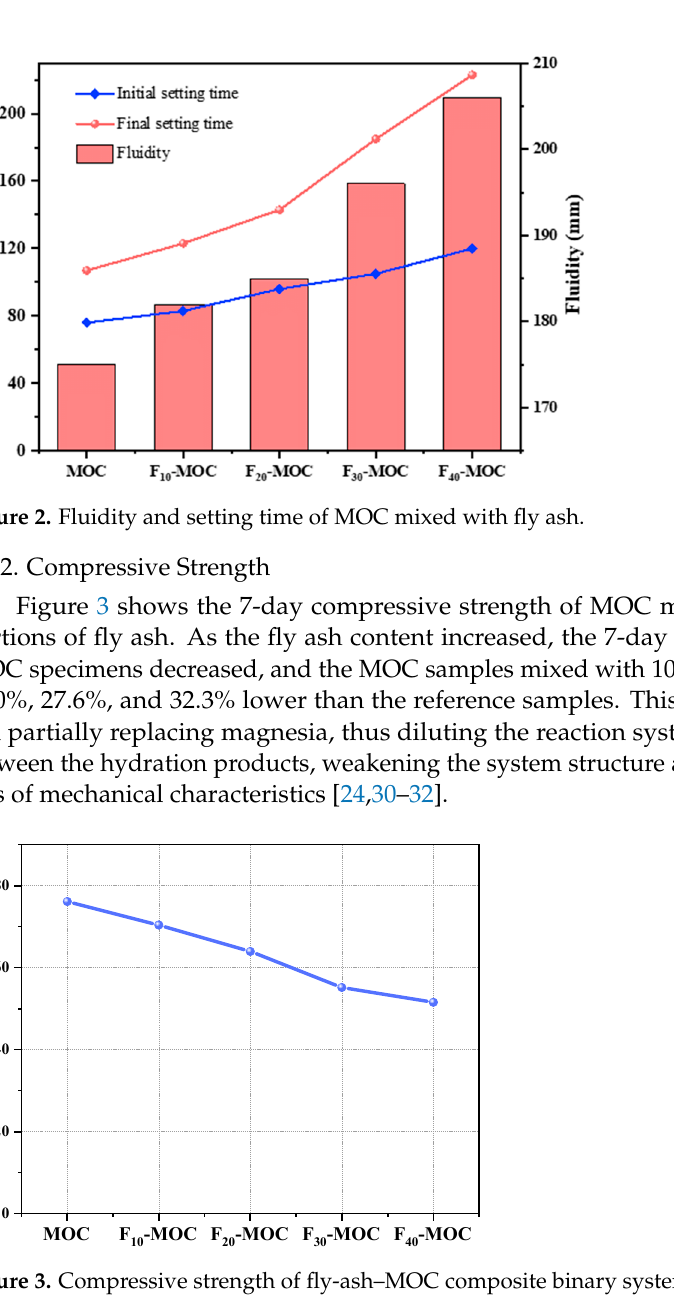
( b ) Figure 4. Water resistance of fly ‐ ash–MOC composite binary system: ( a ) 7 d compressive strength; and ( b ) 7 d strength residual coefficient after immersion in water.